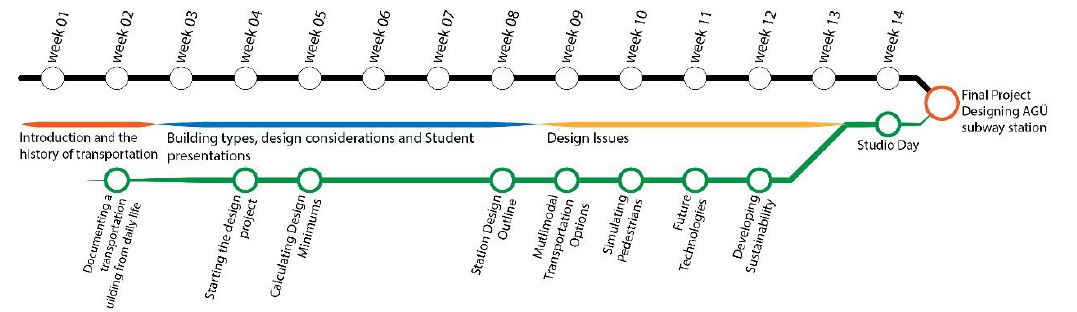
Figure 1 Class structure diagram showing the process of the whole semester